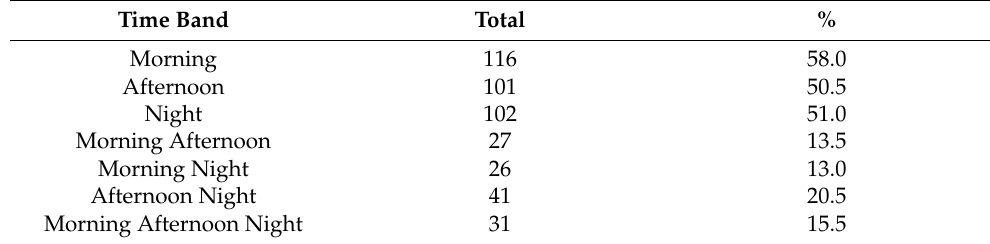
Table 6. Partial scenarios: Number of parking spaces by time band in which they appear active.